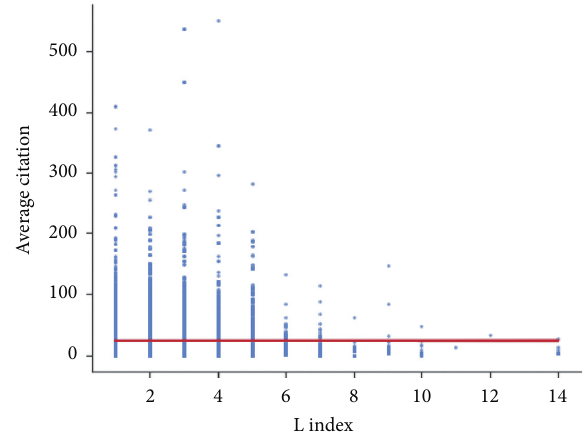
Figure 10: Scatter diagram and regression curve of correlation between average citations per paper and